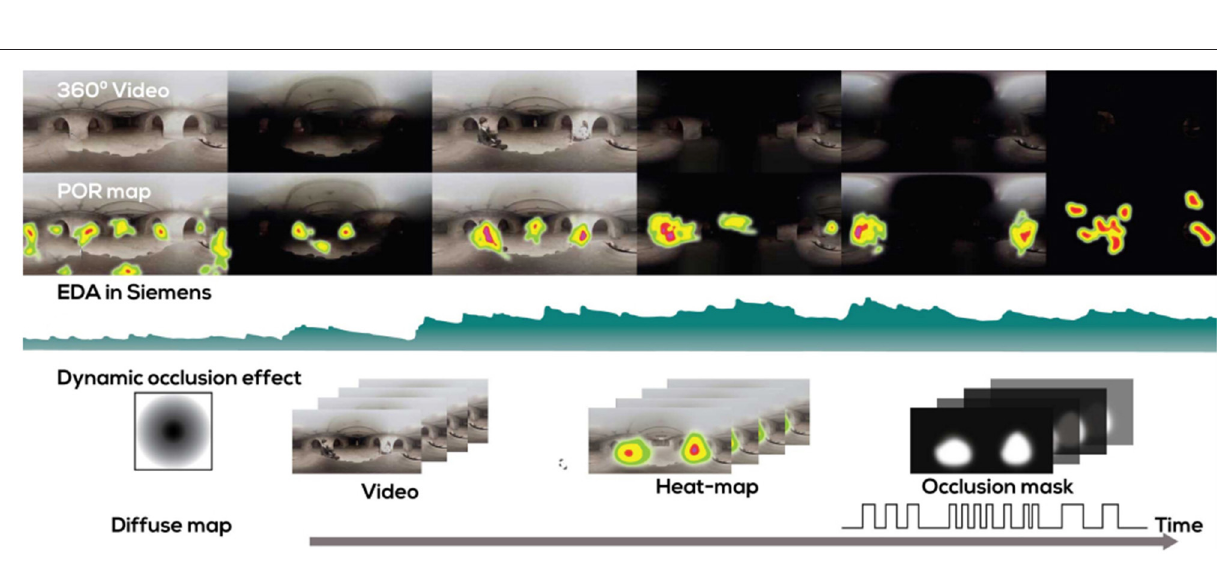
FIGURE 8 | A 360 video scene is manipulated by the user’s gaze data and skin conductance response data to increase the users’ arousal levels. These arousal levels create darker flashing moments making it more dramatic, similar to those seen in horror movies. To direct the user’s focus to the people within the video, the system modulates a surface shader dynamically that occludes locations informed by the gaze tracking system’s data as areas that are not of interest to the